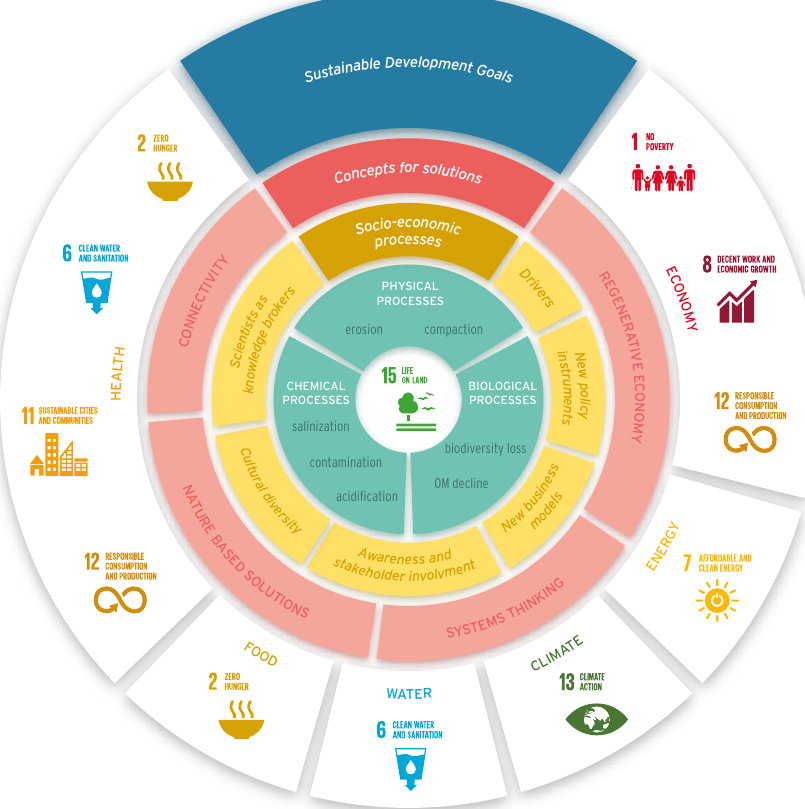
Figure 3. Schematic view of the linkages between the Sustainable Development Goals, societal challenges, concepts in soil, land and water management, and indicators and processes in the biosphere (biological, chemical, and physical